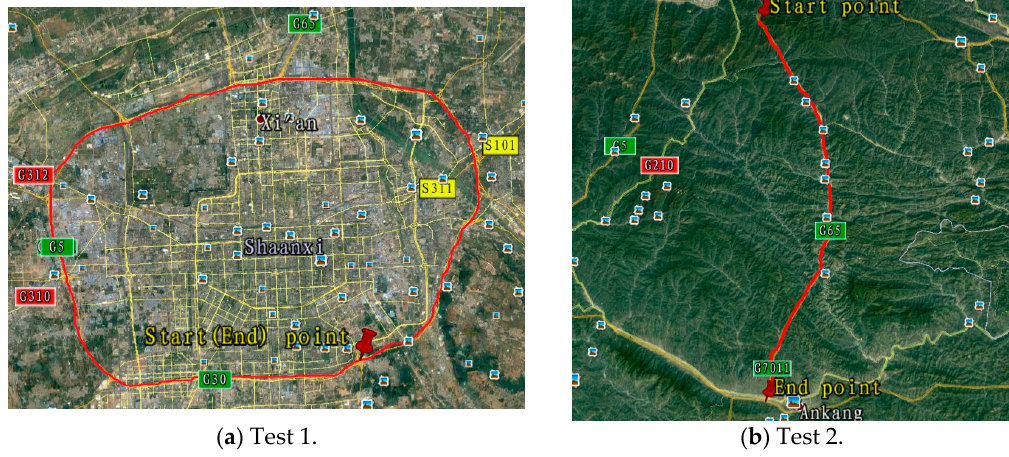
Figure 9. Field test trajectories on Google map. Sensors 2016 , 16 , 2019